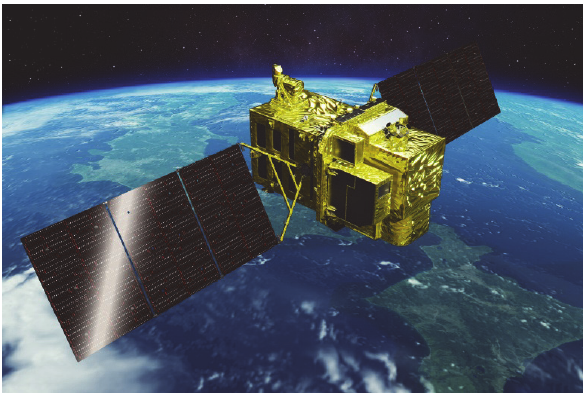
Figure 1. In-orbit configuration of ALOS-3